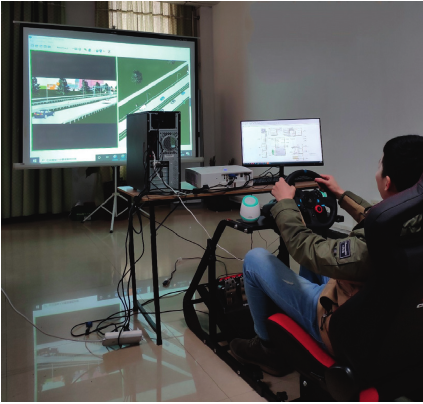
Figure 7: Driver-in-the-loop test platform.